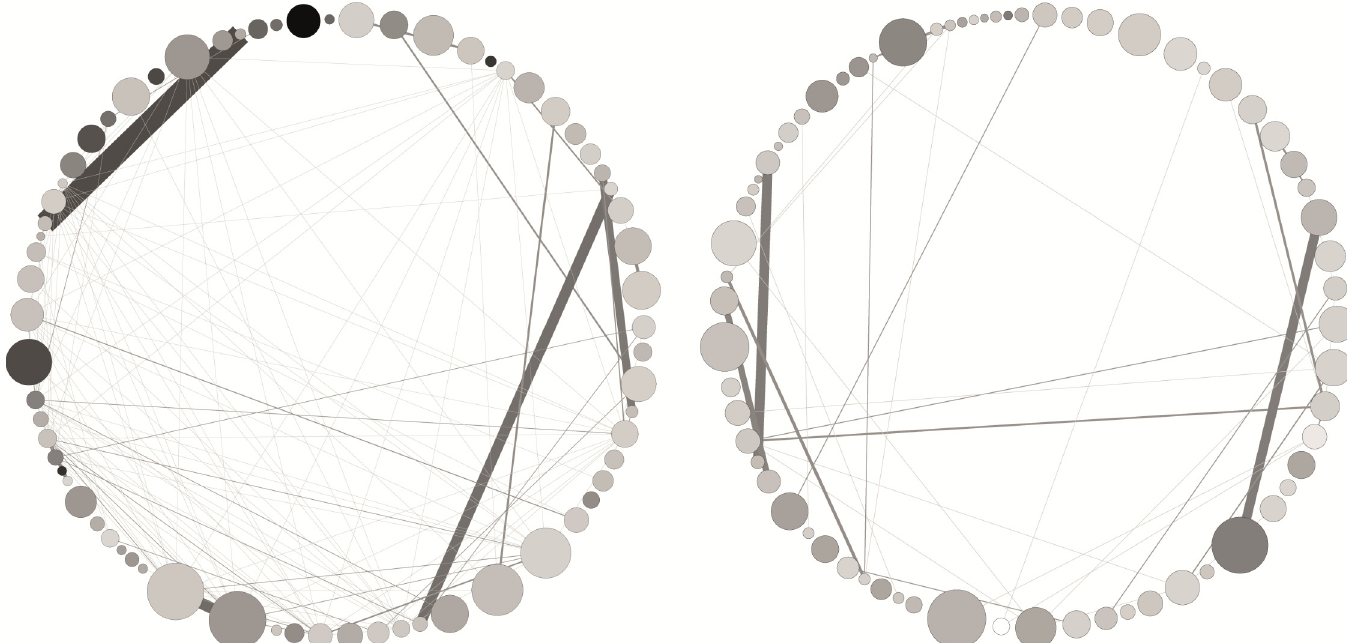
Fig 2. Circular Hierarchy of Coauthor Relations Among Nobel Laureates (left) and Non-Laureates (right). Authors are arranged clockwise starting from top center in ascending order from the year of first publication. The size of the nodes indicates the average number of citations received per paper produced by each scientist. Color of the nodes indicates the percentage of sole-authored publications in lifetime output, ranging from 0% (white) to 78.6% (black). Thickness of the edges indicates the number of co-authored publications.